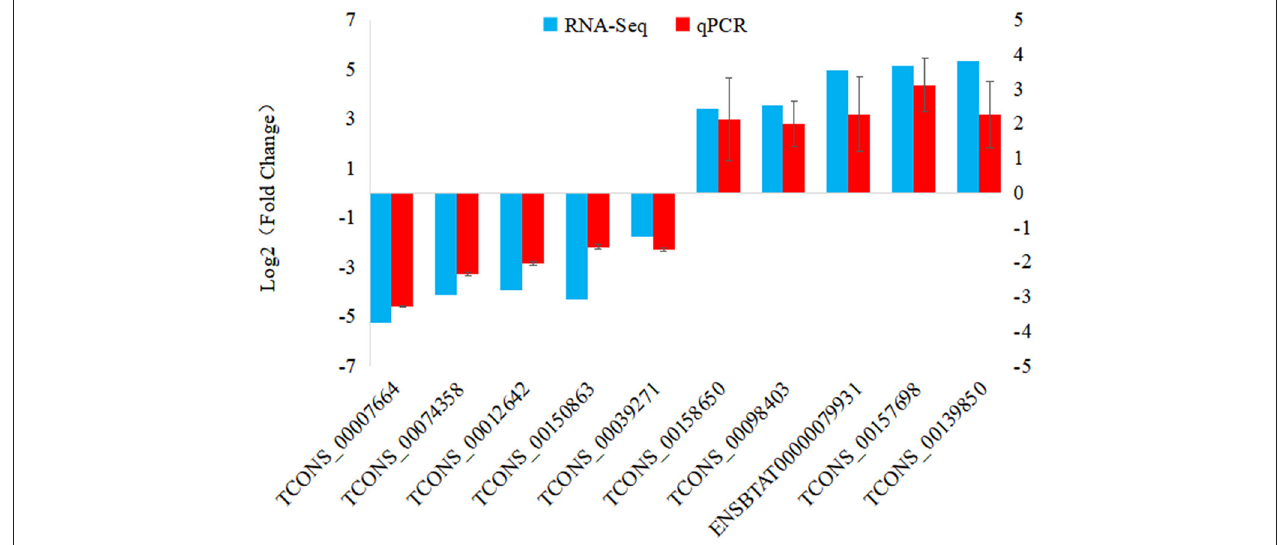
FIGURE 5 | qRT-PCR validation of DElncRNAs. 10 DElncRNAs were used for qRT-PCR validation, with TCONS_00074358 from 6 hpi VS. 0h comparison; TCONS_00012642, TCONS_00150863, TCONS_00039271, ENSBTAT00000079931, TCONS_00157698 and TCONS_00139850 from 12 hpi VS. 0h comparison; TCONS_00007664, TCONS_00158650 and TCONS_00098403 from 12 hpi VS. 6 hpi